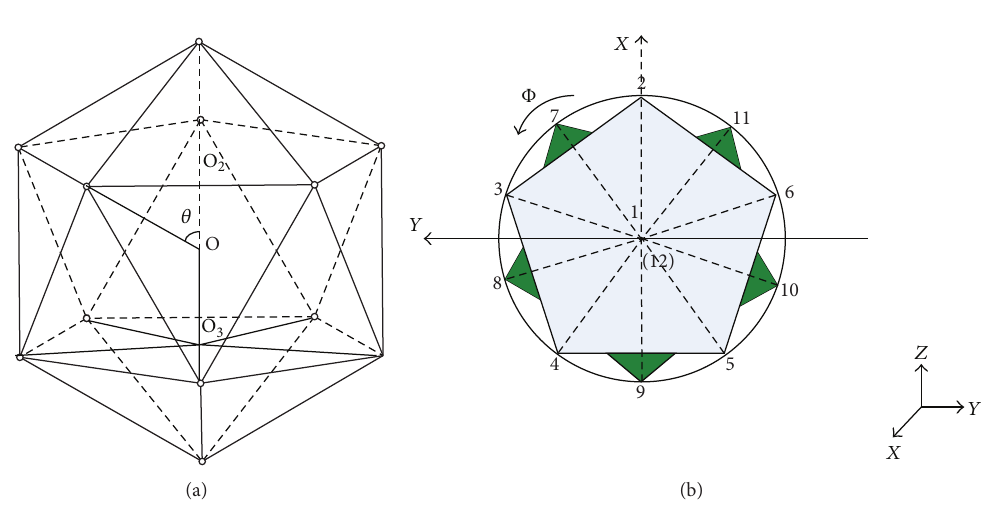
Figure 2: Regular icosahedron in the interior of wavefront